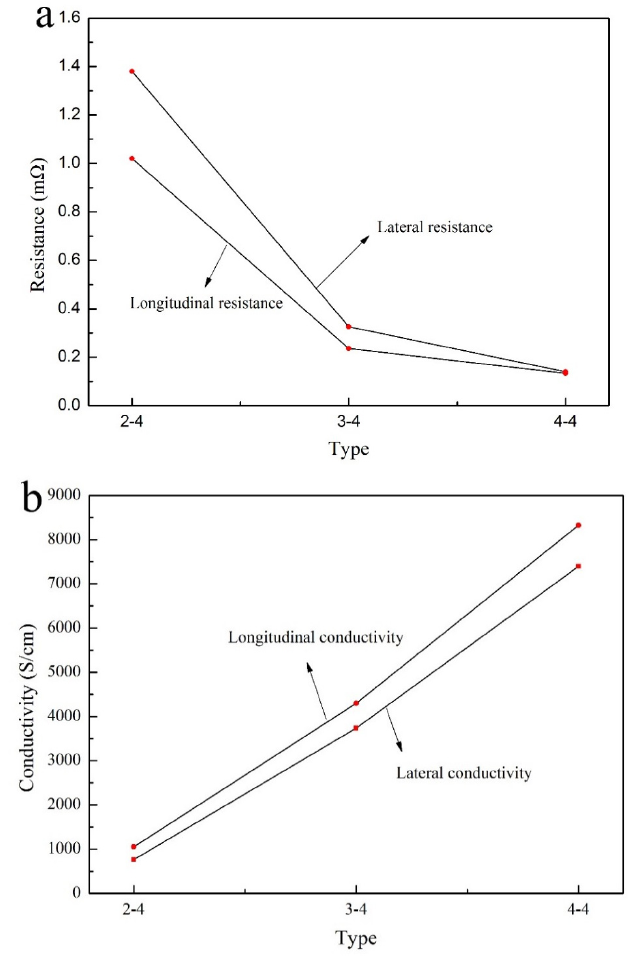
Figure 3. Electrical properties. ( a ) Resistance; ( b ) conductivity. Table 6. Relationship between electroless times and composite coatings resistance.